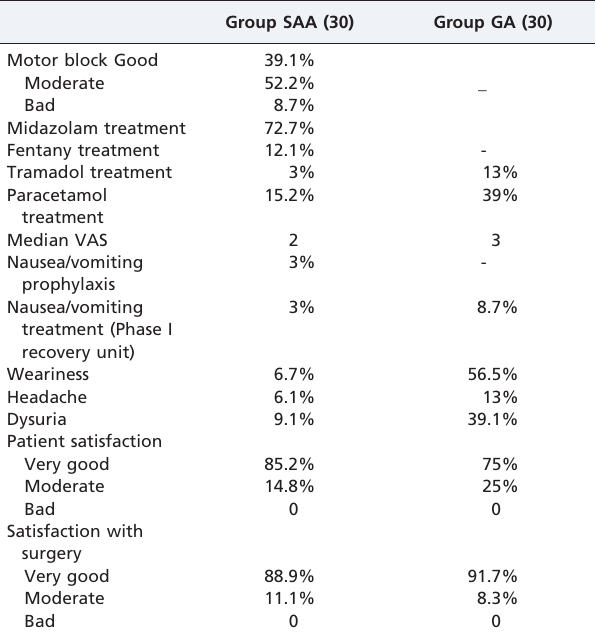
Table 3 - Post-operative clinical